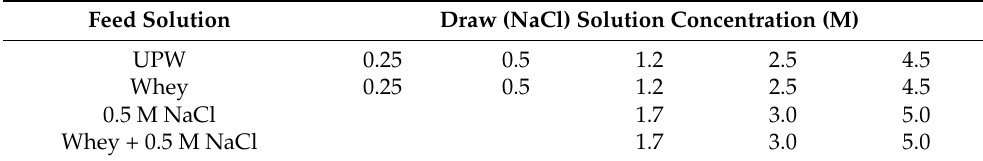
Table 3. FO test